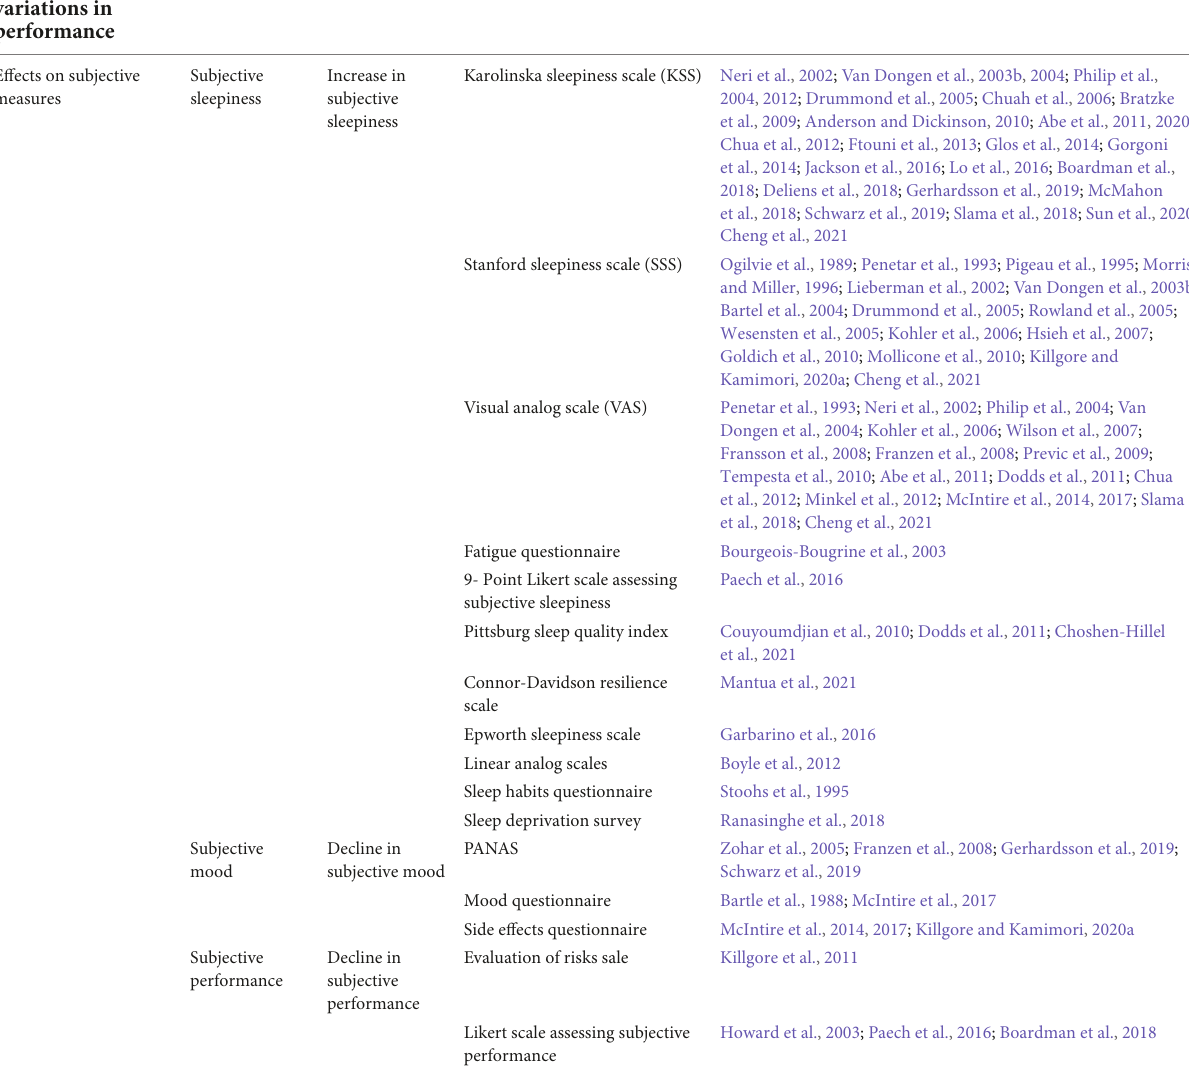
TABLE 3 Summary of the types of measurements for different types of effects of fatigue on subjective measures. Fatigue related variations